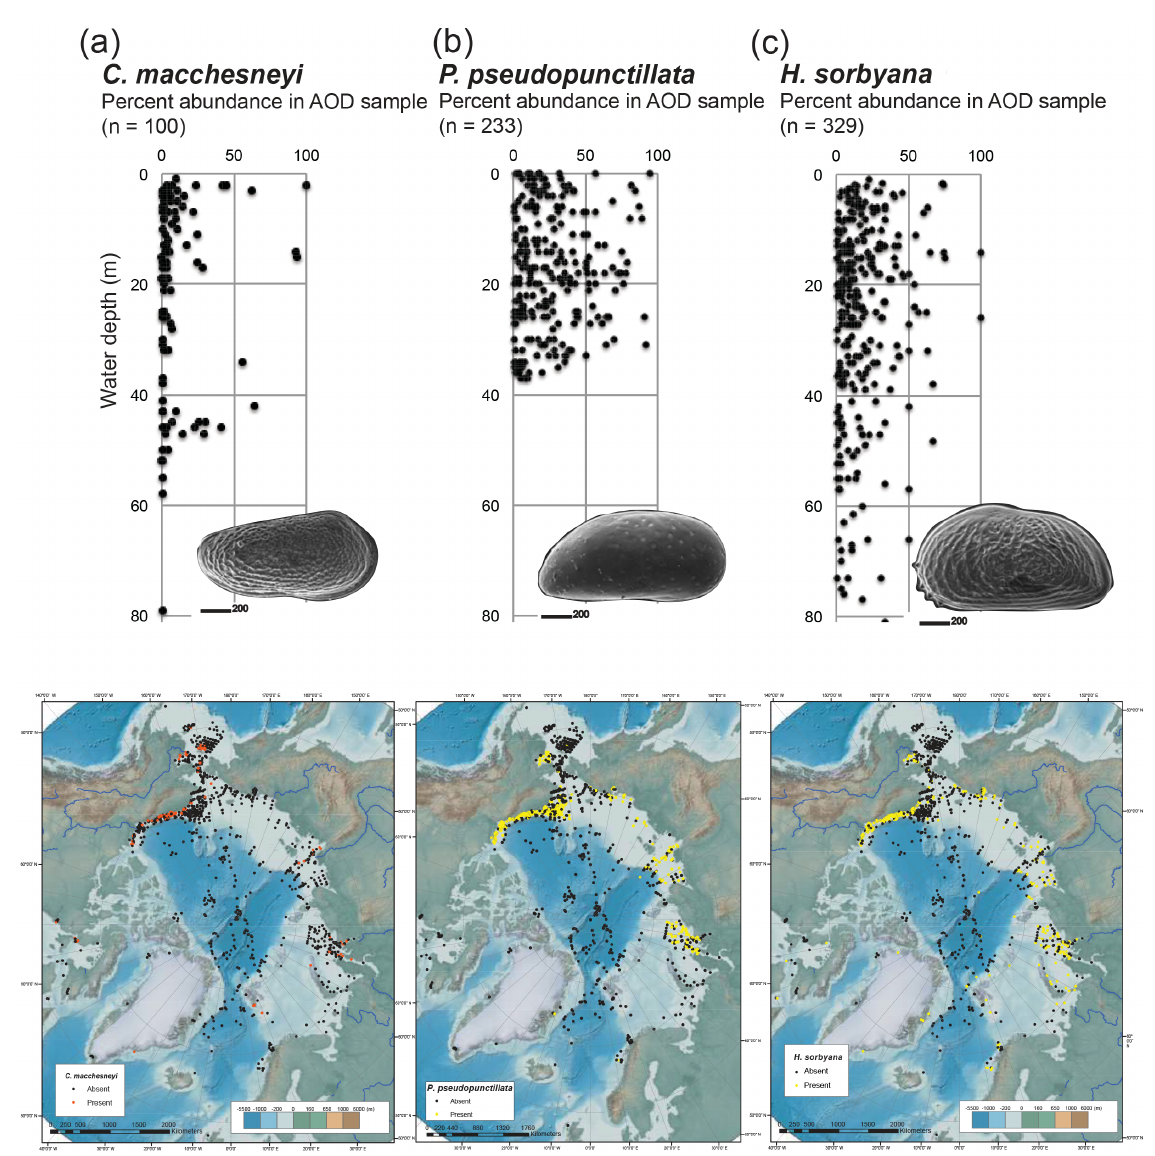
Figure 6. The ostracodes (a) Cytheromorpha macchesneyi , (b) Paracyprideis pseudopunctillata , and (c) Heterocyprideis sorbyana (from 4-PC1) are plotted showing the percent abundance of each species at modern depths based on the 1200-sample modern Arctic Ostracode Database (AOD; Gemery et al., 2015). Only modern AOD samples with >50 total ostracode specimens were used. Rabilimis (not shown) is also a marginal marine indicator species found in core